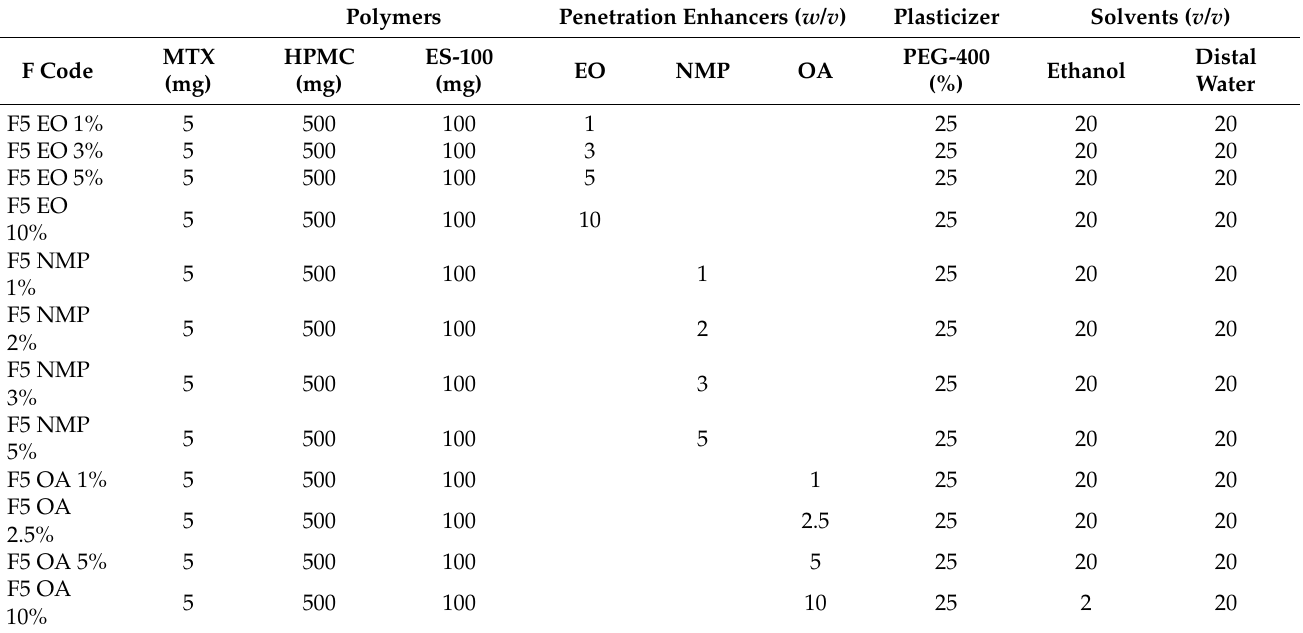
Table 5. Preparation of methotrexate transdermal patch formulations with penetration enhancers.